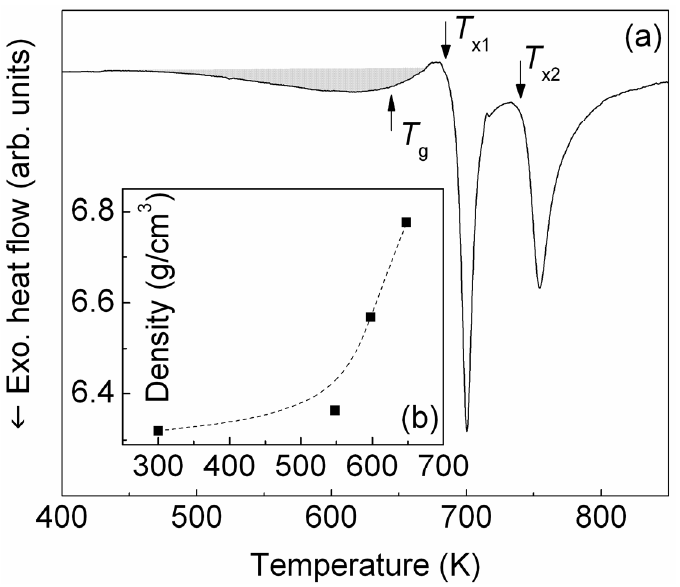
Figure 1. ( a ) Isochronal (40 K/min) DSC scan of the as-cast rod; and ( b ) density of the metallic glass as a function of the annealing temperature.